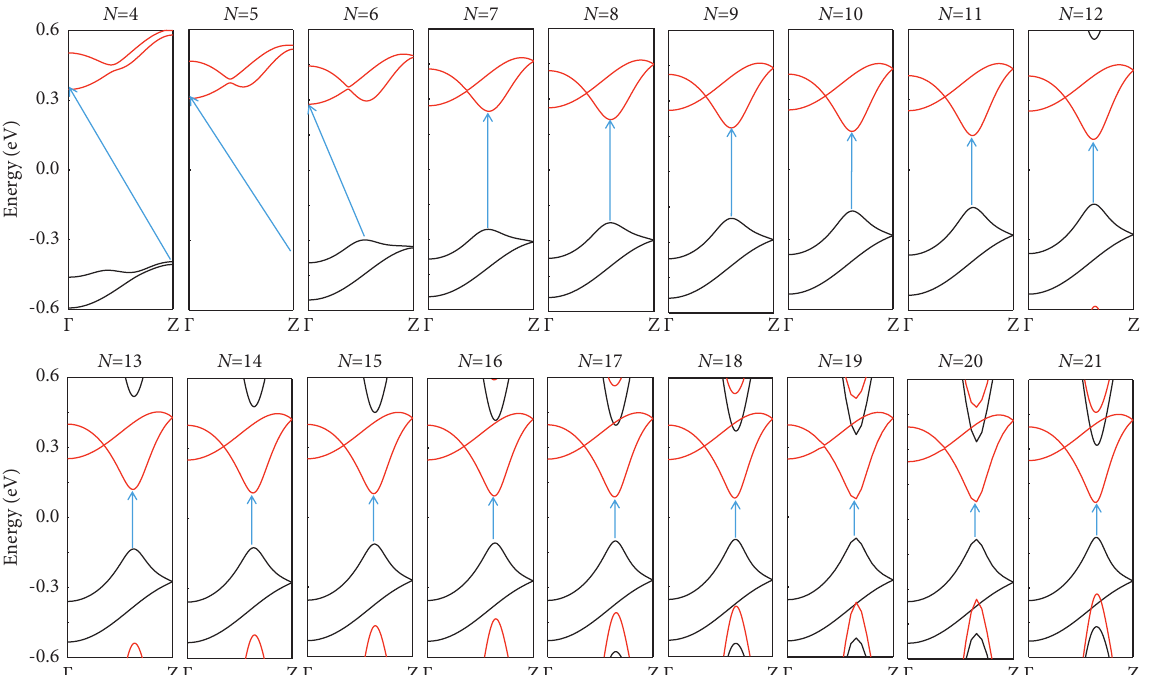
Figure 3: Spin-dependent band structures of the N-ZKGNRs ( N � 4–21). The black and red lines represent spin-up and spin-down electrons,